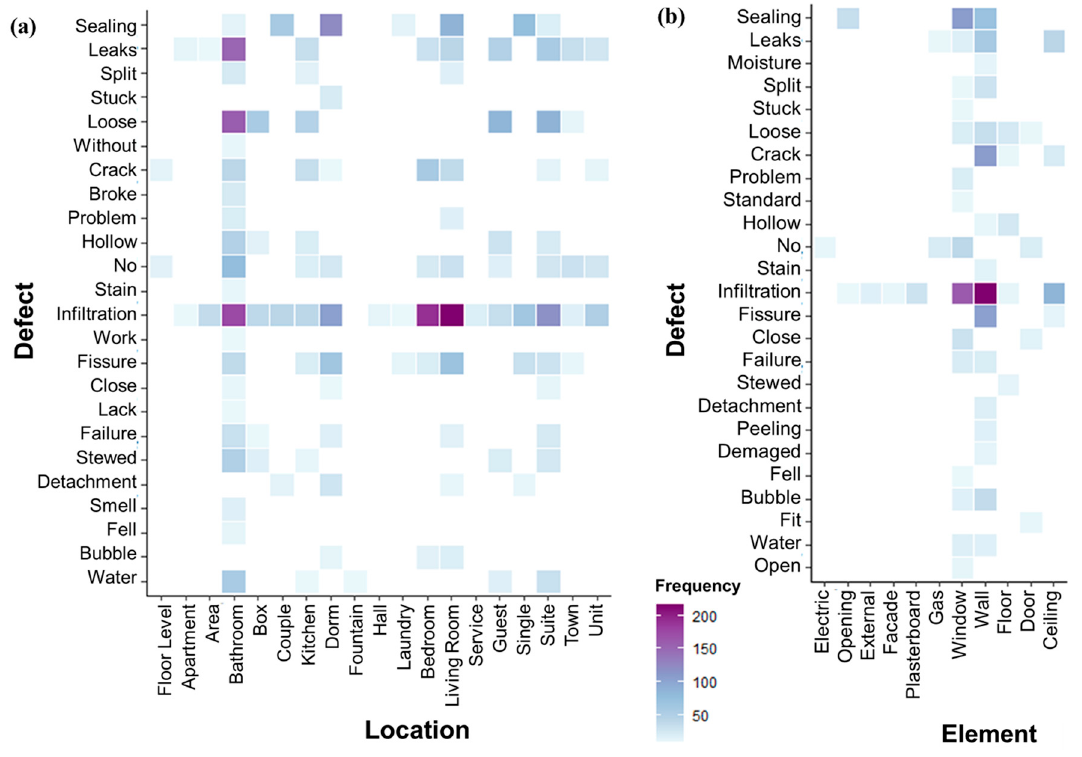
Figure 6. Frequency analysis of ( a ) defect × location words and ( b ) defect × element words.